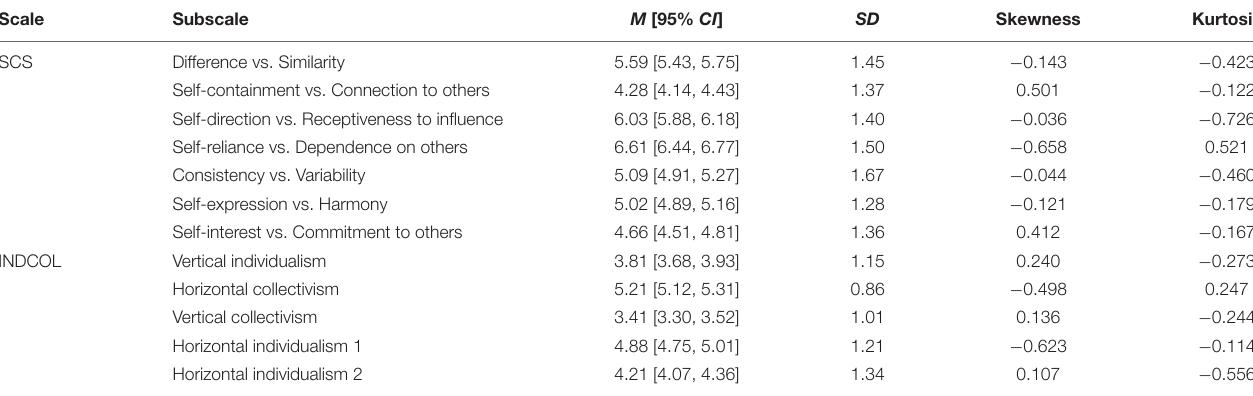
TABLE 2 | The descriptive statistics of subscale